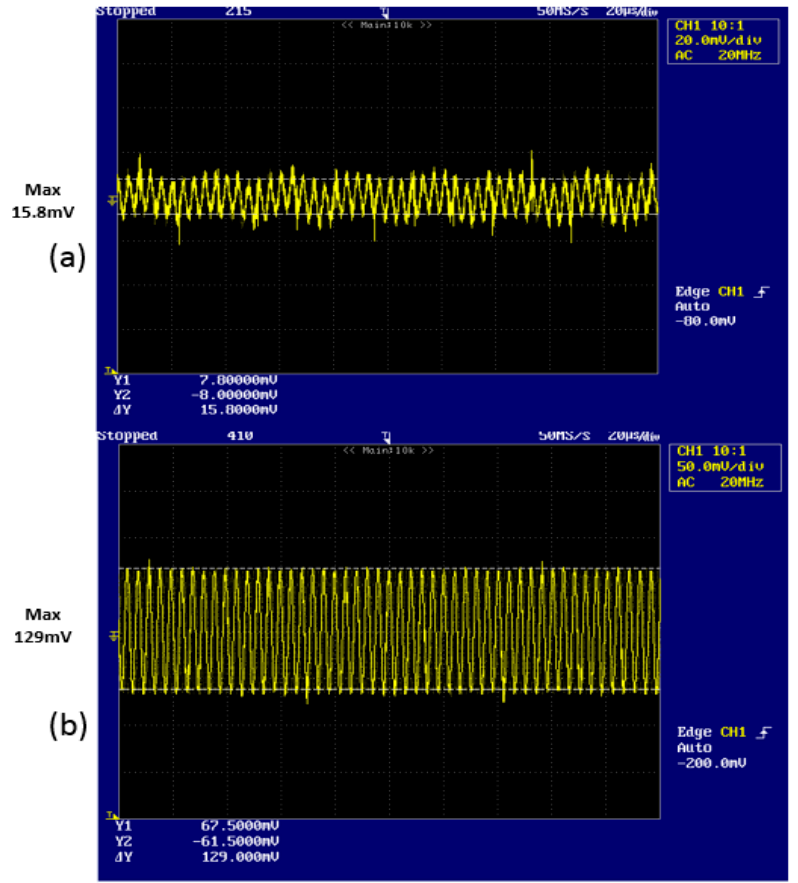
Figure 10. Output signal of received modulated wave with frequency 250 kHz, and maximum voltage: ( a ) 15.8 mV; and ( b ) 129 mV.